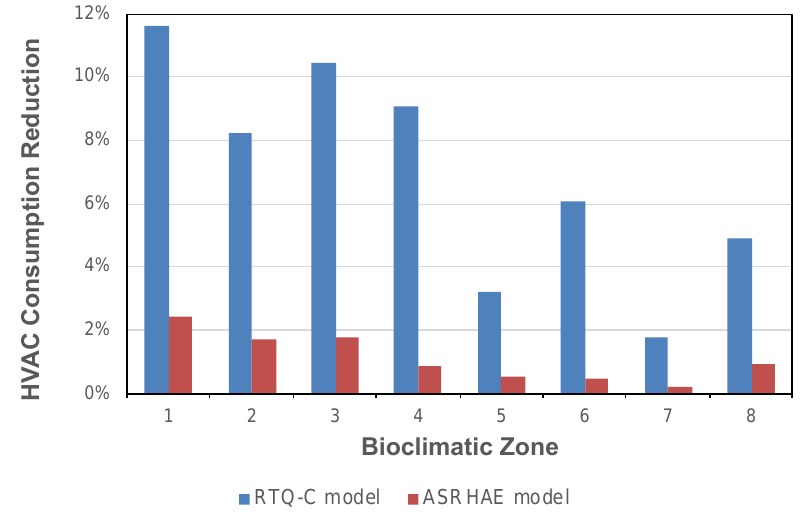
Figure 7. HVAC reduction for T ctw isolated optimisation control.